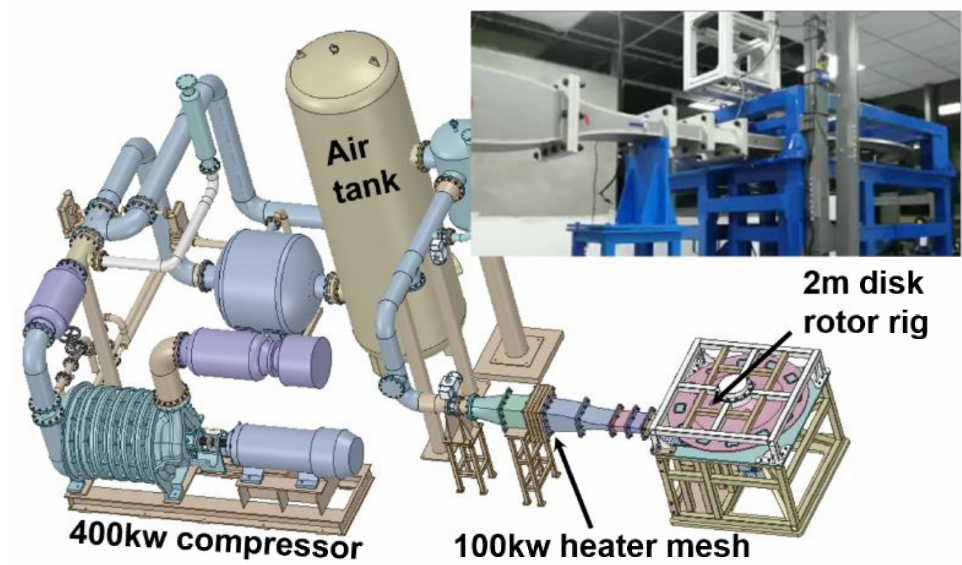
Figure 11. High-speed wind tunnel system employed in present study.